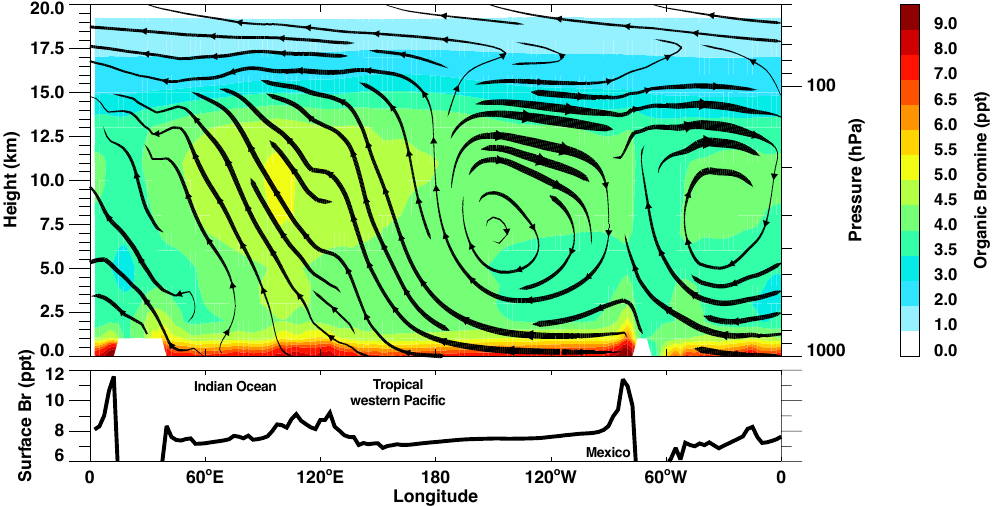
Figure 7. Longitude-height cross section of modeled total VSL organic bromine (CHBr 3 × 3+CH 2 Br 2 × 2) (color contours) and streamlines (black lines) in the deep tropics. The organic bromine and wind streams are 10-year annual averages (2001–2010) between 10 ◦ S and 10 ◦ N. Surface organic bromine abundance is shown as the black solid graph at the bottom